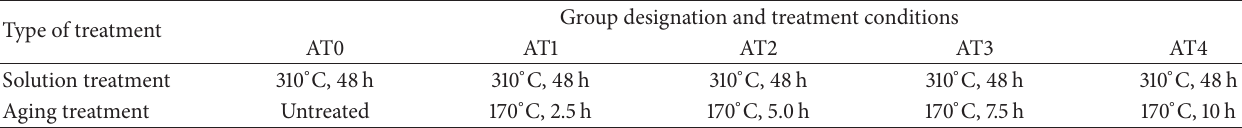
Table 1: Details of the heat treatment parameters of the Mg-35Za-3Ca alloy.